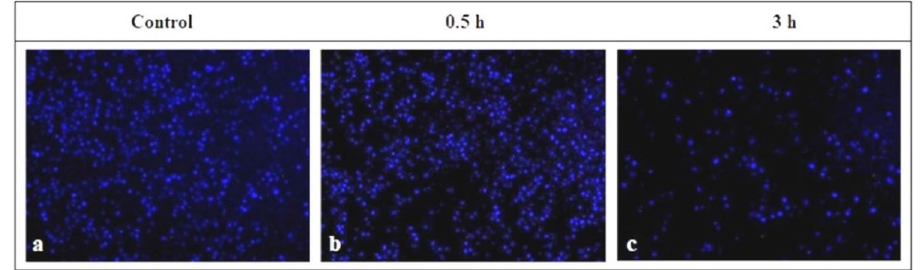
Figure 6. Pre-exposure of THP-1 cells to 15 Pa shear stress decreases their adhesion to HUVEC cells. THP-1 cells, which were pre-labeled with Hoechst 33342 (blue), were exposed to 15 Pa for 0.5 h or 3 h. THP-1 cells were then placed on TNF-alpha-pre-stimulated HUVEC cells for 3 h. After non-adherent THP-1 cells were removed, Hoechst 33342-stained-THP-1 cells (blue), which were attached to HUVEC cells, were monitored by a Zeiss Axio A1 fluorescence microscope. ( a ) THP-1 cells, which were placed on HUVEC cells in a static environment without exposing to a flow; ( b ) THP-1 cells, which were pre-exposed to 15 Pa shear stress for 0.5 h were placed on HUVEC cells, and ( c ) THP-1 cells, which were pre-exposed to 15 Pa shear stress for 3 h were placed on HUVEC cells. The magnification is 10×.